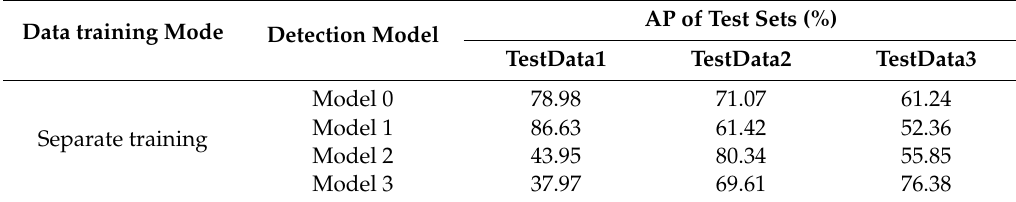
Table 11. Test results of test sets under separate training modes.